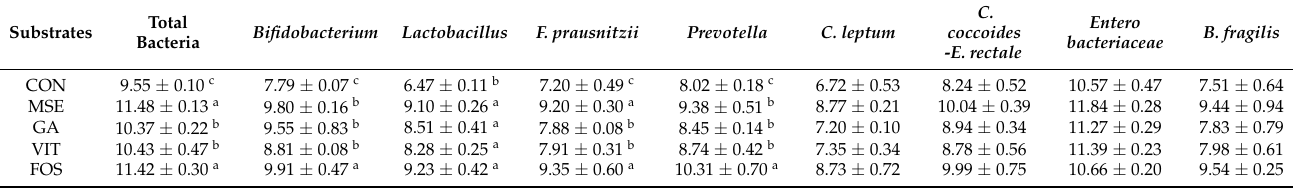
Table 2. Bacterial population (log 10 cell mL − 1 ± standard error of the mean, SEM) in 24 h batch fermentations with mung bean seed coat extract (MSE), gallic acid (GA), vitexin (VIT), fructo- oligosaccharides (FOS), and no added substrate (control;